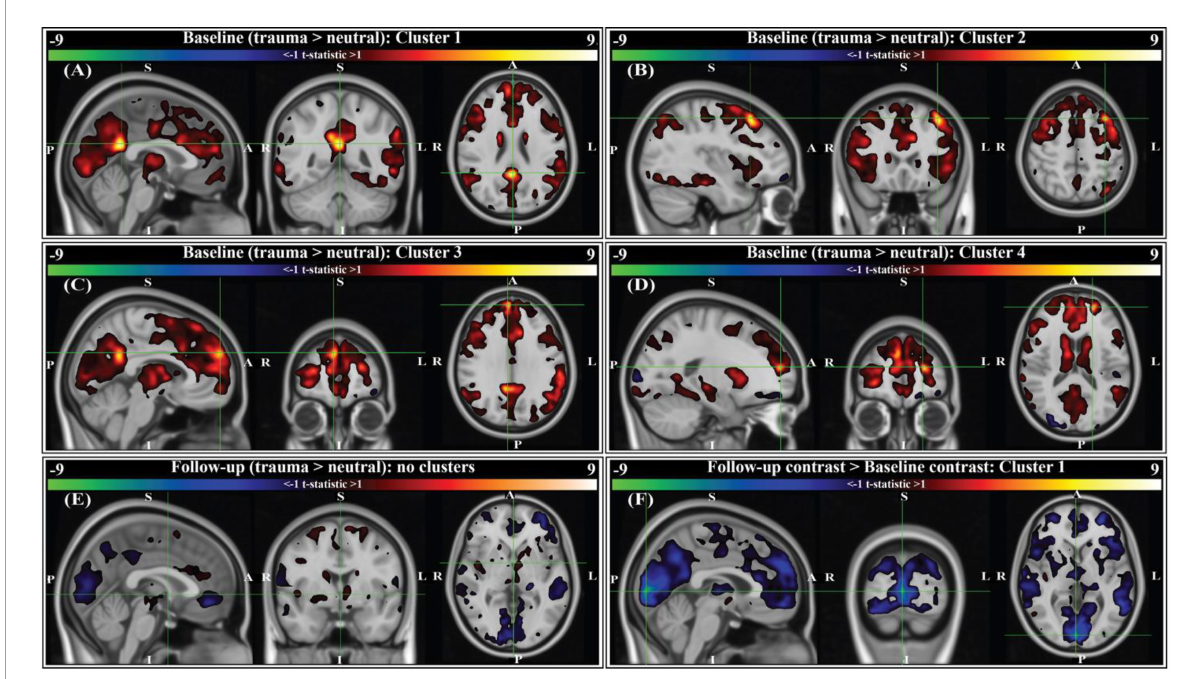
FIGURE4 Group-level activation contrasts for trauma versus neutral script listening tasks ( N = 9). All panels show t-statistics for corresponding contrasts. Analyses were performed in 3 mm MNI standard space, however results here are interpolated into 1 mm MNI standard space and clipped to only show t -statistics greater than ± 1 for visualization purposes. Statistics reported below (voxels, volume, t-statistic, corrected p -value) were calculated from original 3 mm results. P -values were corrected using threshold-free cluster enhancement (TFCE; see section “2. Methods”). For panels (A–E) , positive t -statistics indicate greater activation to trauma scripts compared to neutral. For panel (F) , sign indicates the direction of change in trauma > neutral contrast from baseline (i.e., negative t -statistics indicate the contrast between trauma and neutral scripts was decreased at the two-month follow-up compared to baseline). Crosshairs are located on the center of gravity (c.o.g.) of significant clusters. (A) Cluster 1 for the baseline contrast is located primarily in the right and left isthmus cingulate, with some overlap into the right and left precuneus (c.o.g. MNI152 [0, –48, 24]; 6 voxels (162 mm 3 ); c.o.g. t = 9.61, p (TFCE) = 0.0293). (B) Cluster 2 for the baseline contrast is located in the left caudal middle-frontal gyrus (c.o.g. MNI152 [-36, 21, 51]; 3 voxels (81 mm 3 ); c.o.g. t = 9.01, p (TFCE) = 0.0234). (C) Cluster 3 for the baseline contrast is located in the right medial prefrontal cortex (c.o.g. MNI152 [6, 57, 30]; 2 voxels (54 mm 3 ); c.o.g. t = 7.41, p (TFCE) = 0.0488). (D) Cluster 4 for the baseline contrast is located in the left rostral middle frontal gyrus (c.o.g. MNI152 [-21, 54, 15]; 1 voxel (27 mm 3 ); c.o.g. t = 9.45, p (TFCE) = 0.0312). (E) There were no significant activation contrasts at the two-month follow-up (crosshairs shown at MNI152 [0, 0, 0]). (F) Comparing the group-level contrasts between time points (follow-up > baseline), there exists one significant cluster located primarily in the right and left cuneus, with some overlap into the right and left lingual gyrus (c.o.g. MNI152 [3, –90, 3]; 47 voxels (1,269 mm 3 ); c.o.g t = –9.31, p (TFCE) =